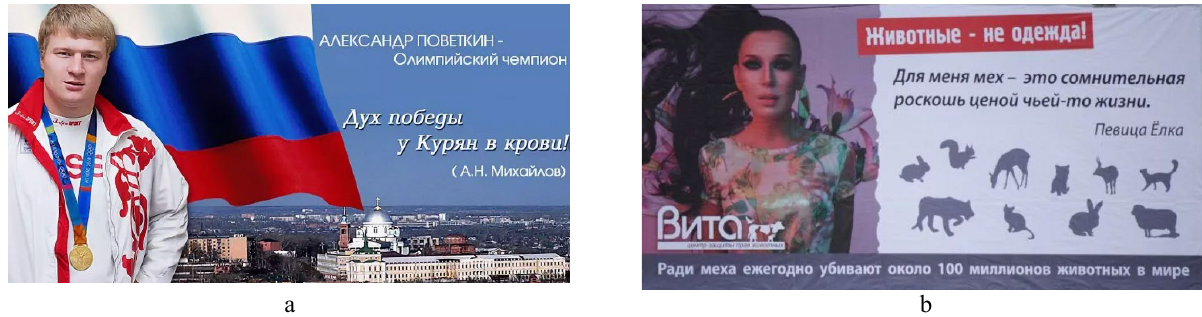
Figure 2 – Examples of non-commercial advertising